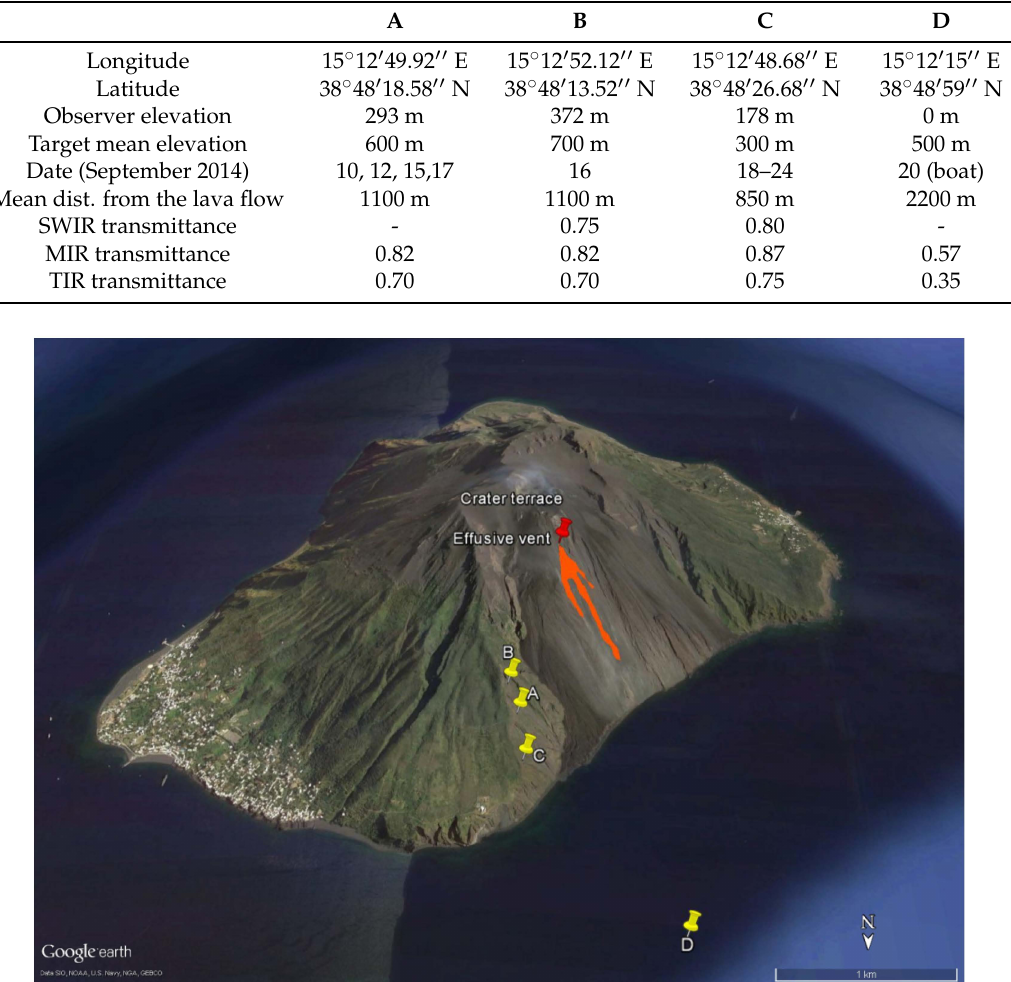
Figure 2. Points represent the position (Table 2) of the effusive vent and the observation points where the thermal cameras were placed (see Table 3). The polygon shows the location of the lava flow on 19 September 2014 at 7:40 p.m. Please note that this is a perspective view from North to